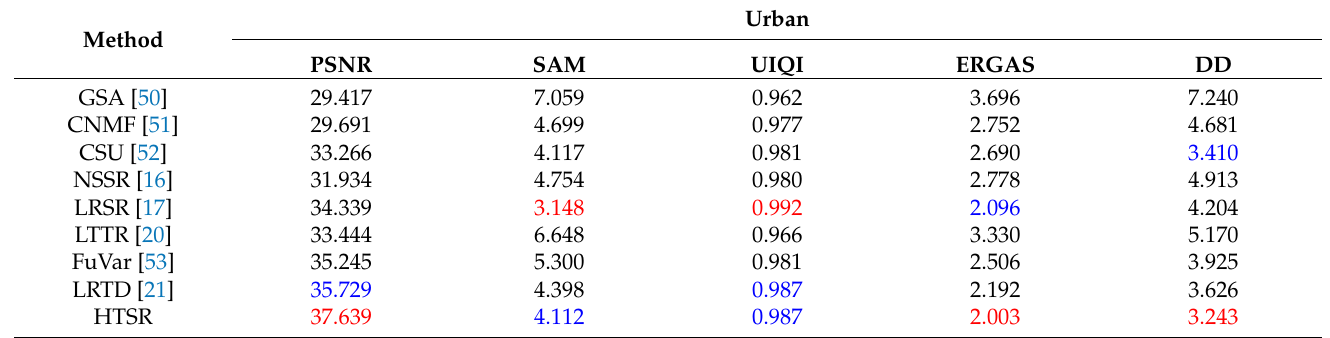
Table 4. Quantitative metrics of the competitive methods on the Urban